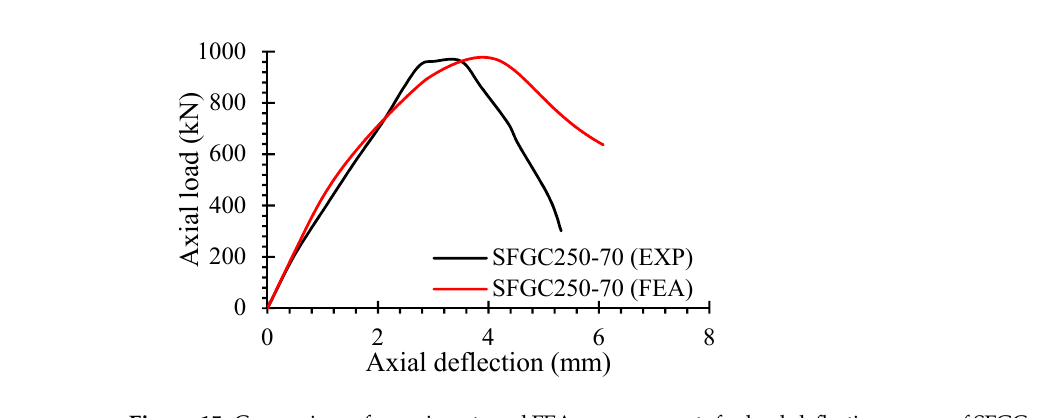
Figure 15. Comparison of experiments and FEA measurements for load-deflection curves of SFGC samples.